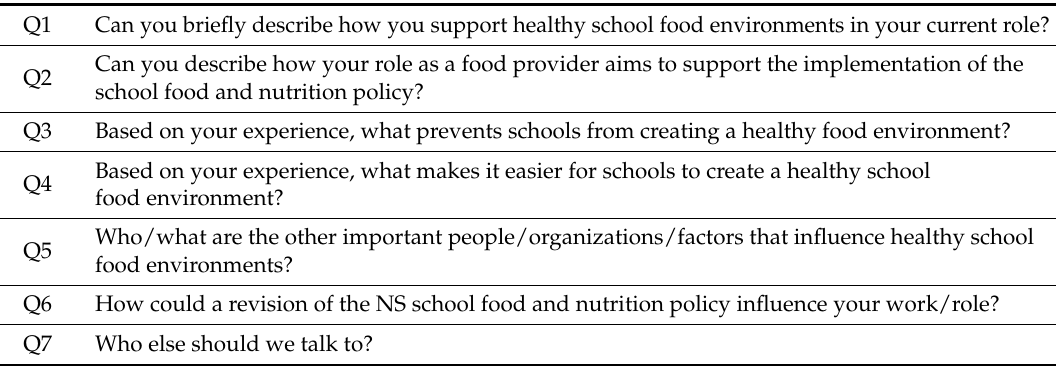
Table 1. Interview questions used in this